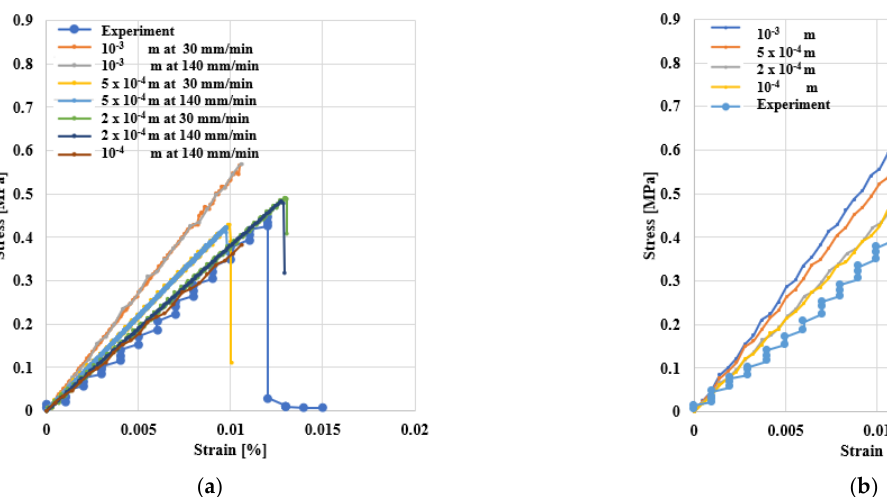
Figure 9. Stress/strain of bitumen beams at different resolutions and loading rate and comparison with other experiments [45]. ( a ) In 3D and ( b ) as a thin plate.